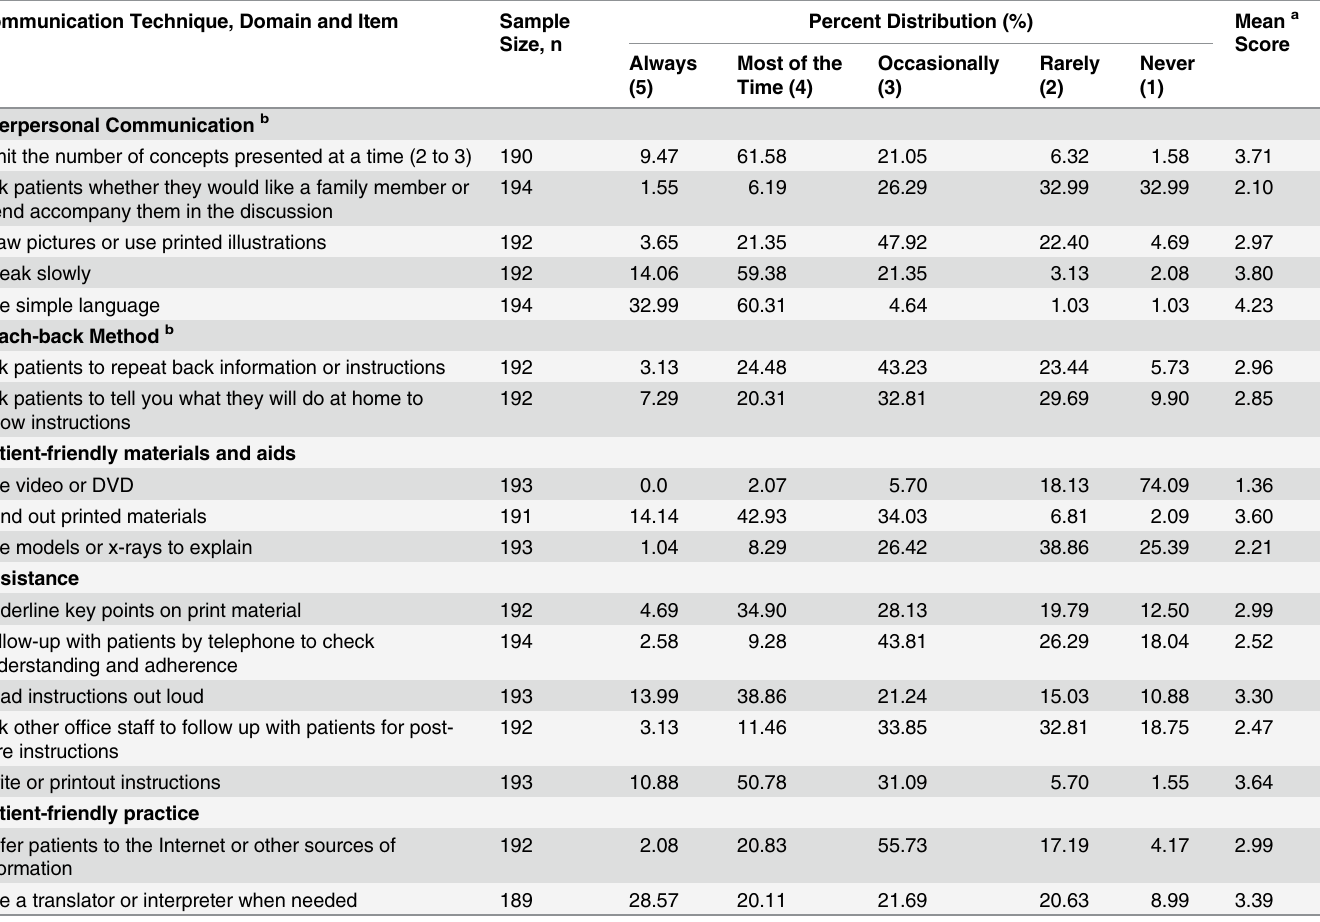
Table 3. Percentage distribution of techniques used routinely by pediatricians and mean Likert scale scores.